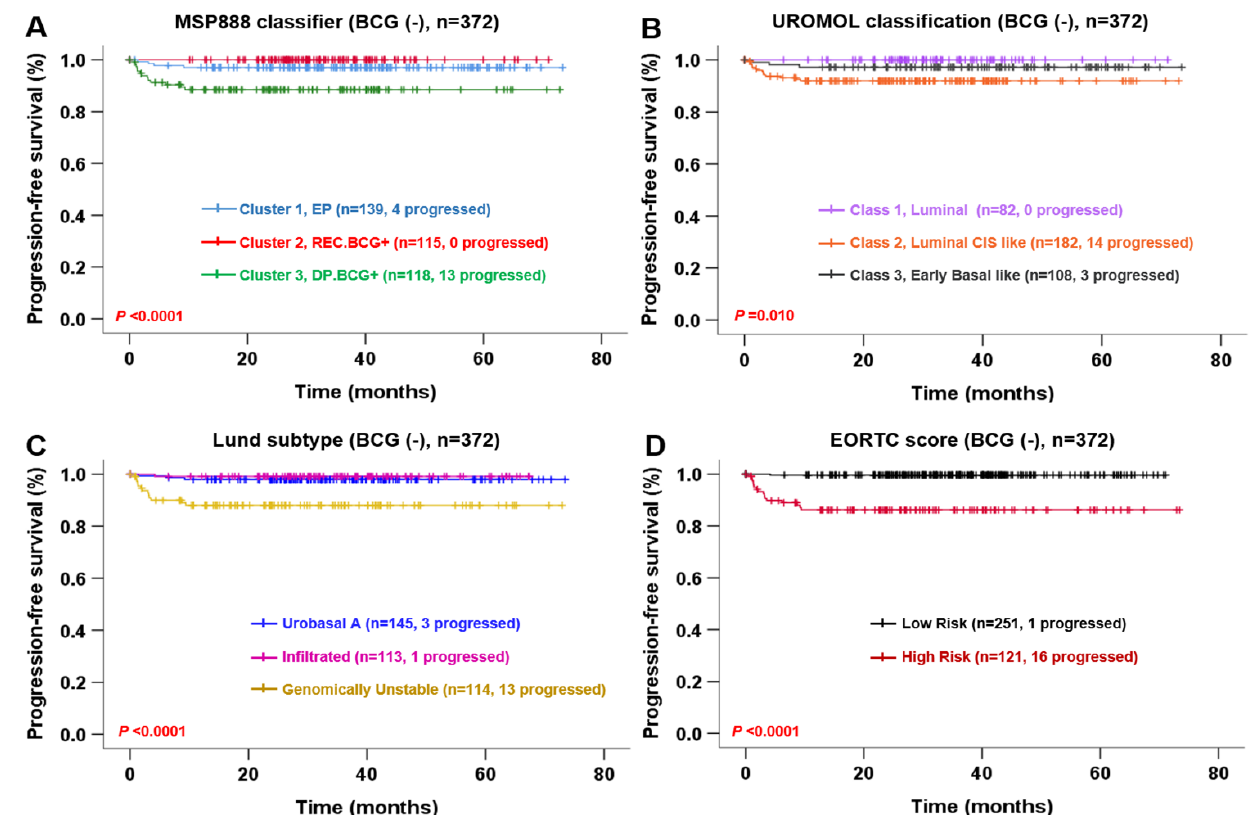
Figure 4. Kaplan–Meier survival curves showing risk of progression in patients in the UROMOL cohort not treated with BCG. Progression‑free survival according to MSP888 classifier ( A ), UROMOL classification ( B ), Lund subtype ( C ) and EORTC risk score ( D ).